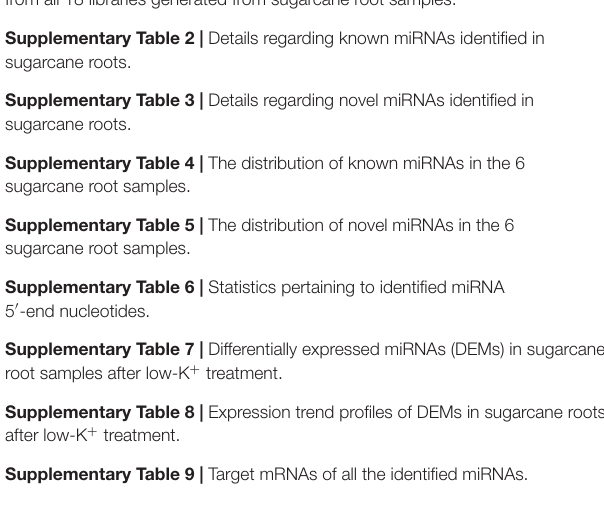
Supplementary Table 8 | Expression trend profiles of DEMs in sugarcane roots after low-K + treatment. Supplementary Table 9 | Target mRNAs of all the identified miRNAs. Supplementary Table 10 | Target mRNAs of differentially expressed miRNAs (DEMs). Supplementary Table 11 | GO annotation of putative target mRNAs of DEMs. Supplementary Table 12 | KEGG annotation of putative target mRNAs of